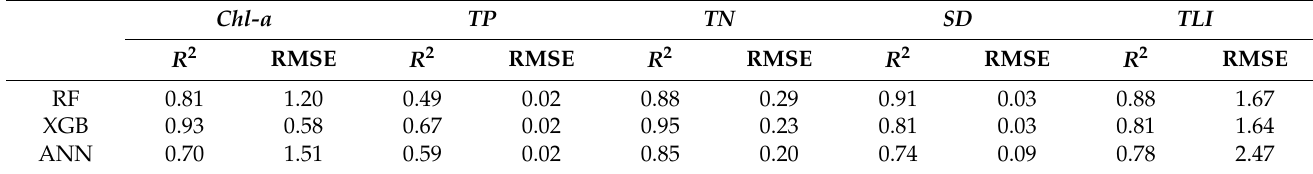
Table 2. Accuracy validation metrics of different regression